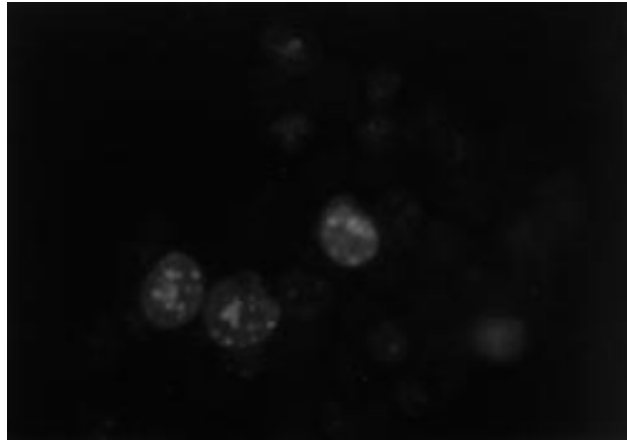
Fig. 1. Dot-like intranuclear staining of MIB-1 in a single-cell suspension prepared from a superficial transitional cell carcinoma of the bladder, grade 2 (original magnification (cid:2) 1000). Cells were fixed with methanol/acetone and stained with an indirect method of